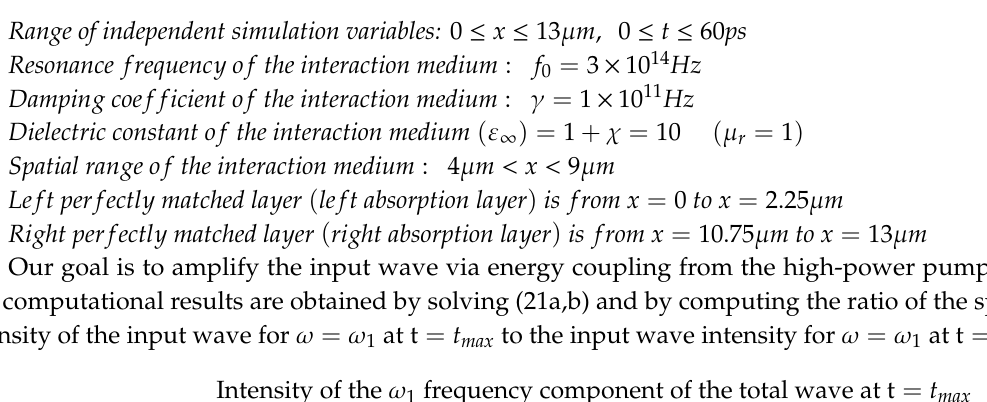
Figure 10. Configuration for optical parametric amplification in example 2.